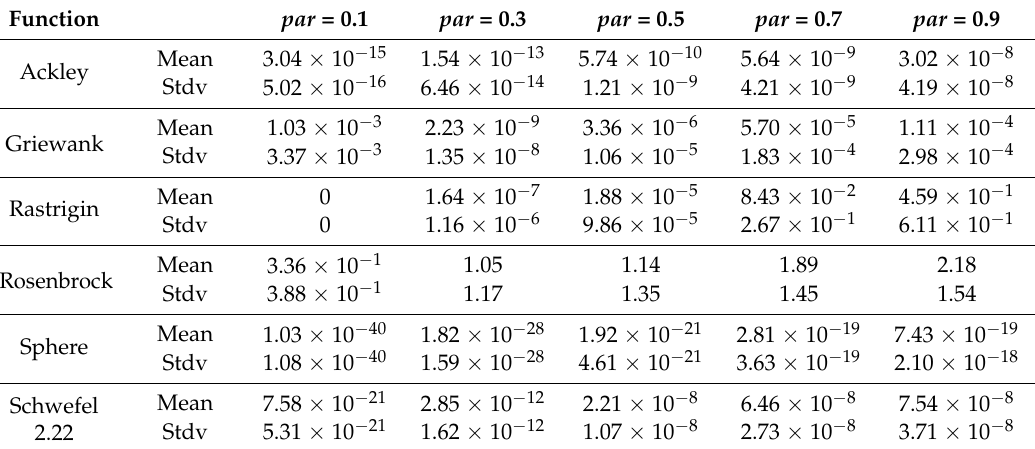
Table 8. The effect of par on the means and standard deviations.